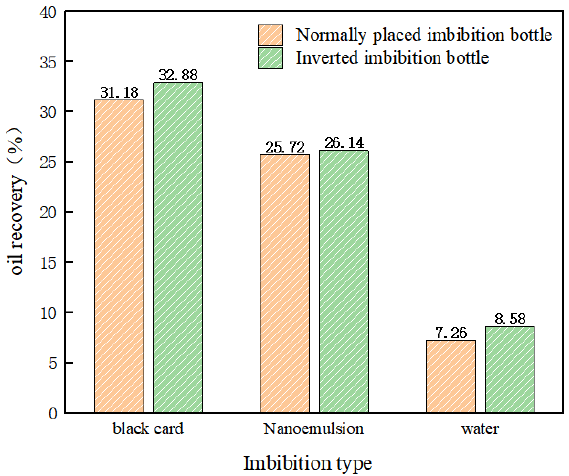
Figure 7. Comparison of recovery degrees of different imbibed fluids.